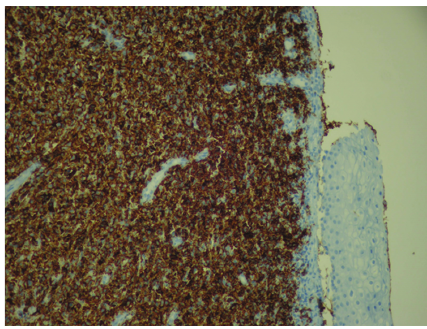
Figure 2: Tumor histology with positive CD20 immunohistochem- ical staining (staining the cell membrane), indicative for B-cell lymphoma.